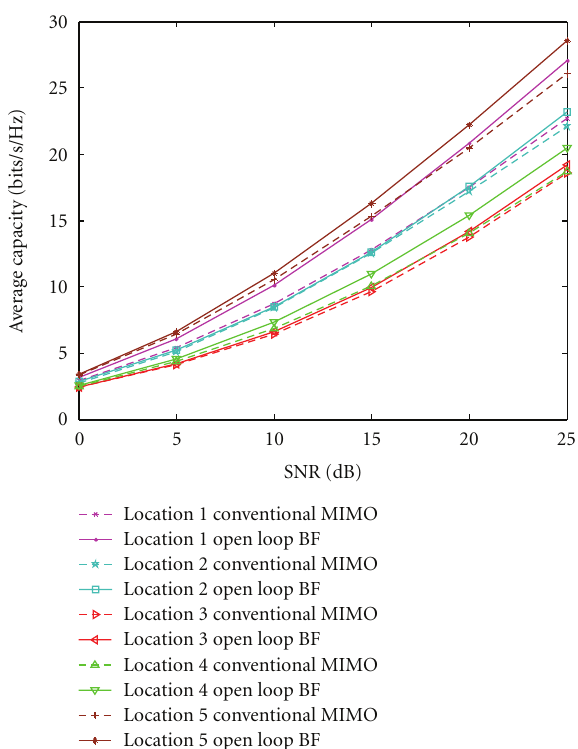
Figure 10: Average capacity (bits/s/Hz) versus SNR (dB) at each location.